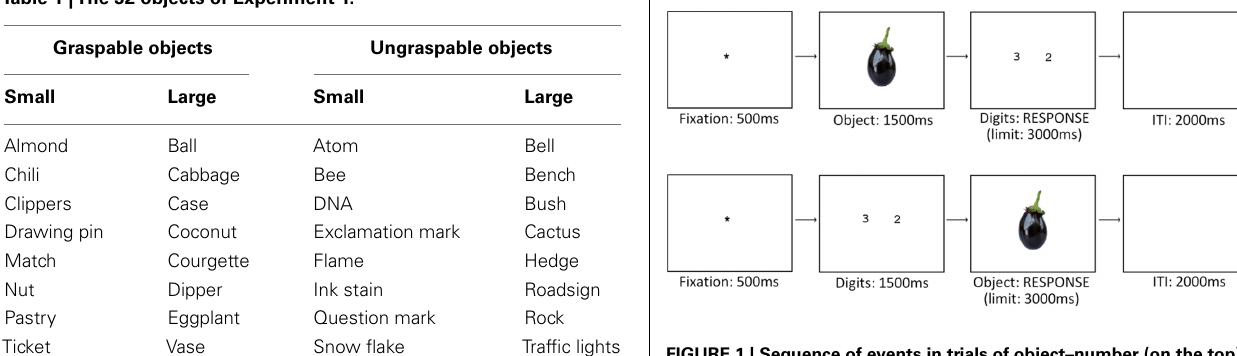
Table 1 |The 32 objects of Experiment 1.